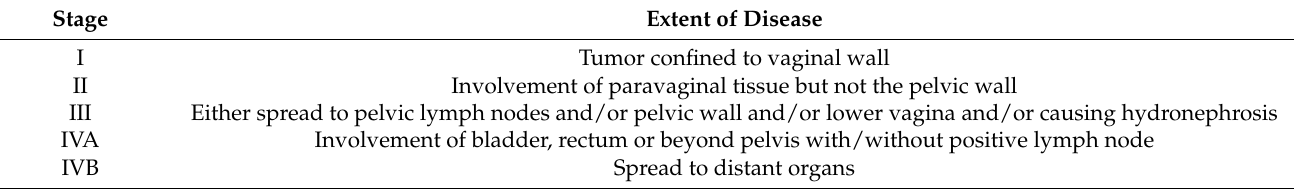
Table 11. 2009 FIGO staging of vaginal cancer.